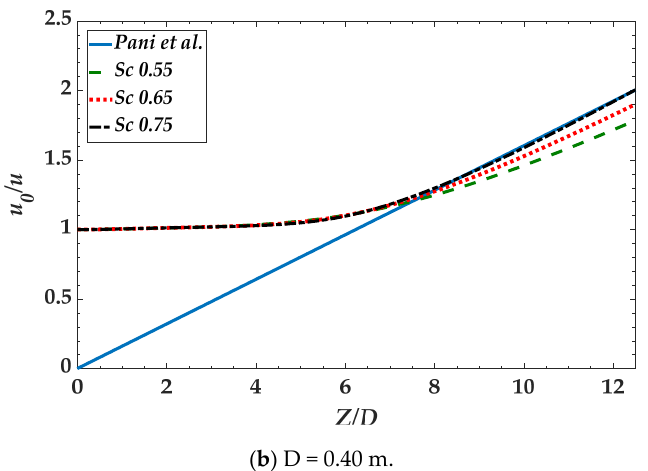
Figure 4. Relationship between dimensionless velocity ( u 0 / u ) and dimensionless distance ( Z / D ) under different turbulent Schmidt numbers.